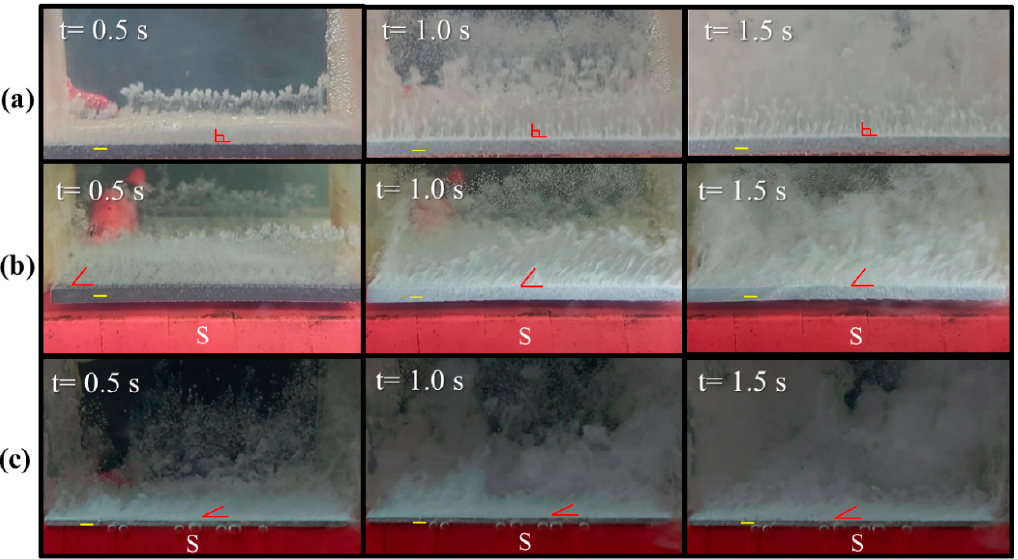
Figure 3. Sequential images of hydrogen bubbles that detach from ( a ) a graphite electrode without a magnet, ( b ) a graphite electrode that faces the S-pole of a magnet, and ( c ) a platinum electrode that faces the S-pole of a magnet: the inter-electrode distance is 5 cm.